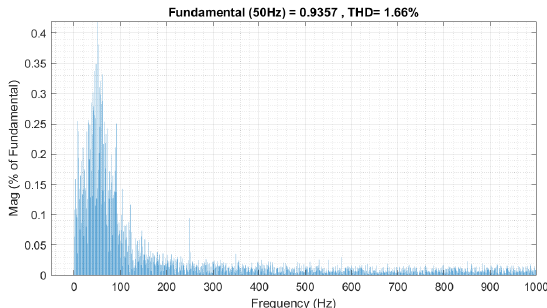
Figure 12. Transformer primary current total harmonic distortion for three EV fast chargers.